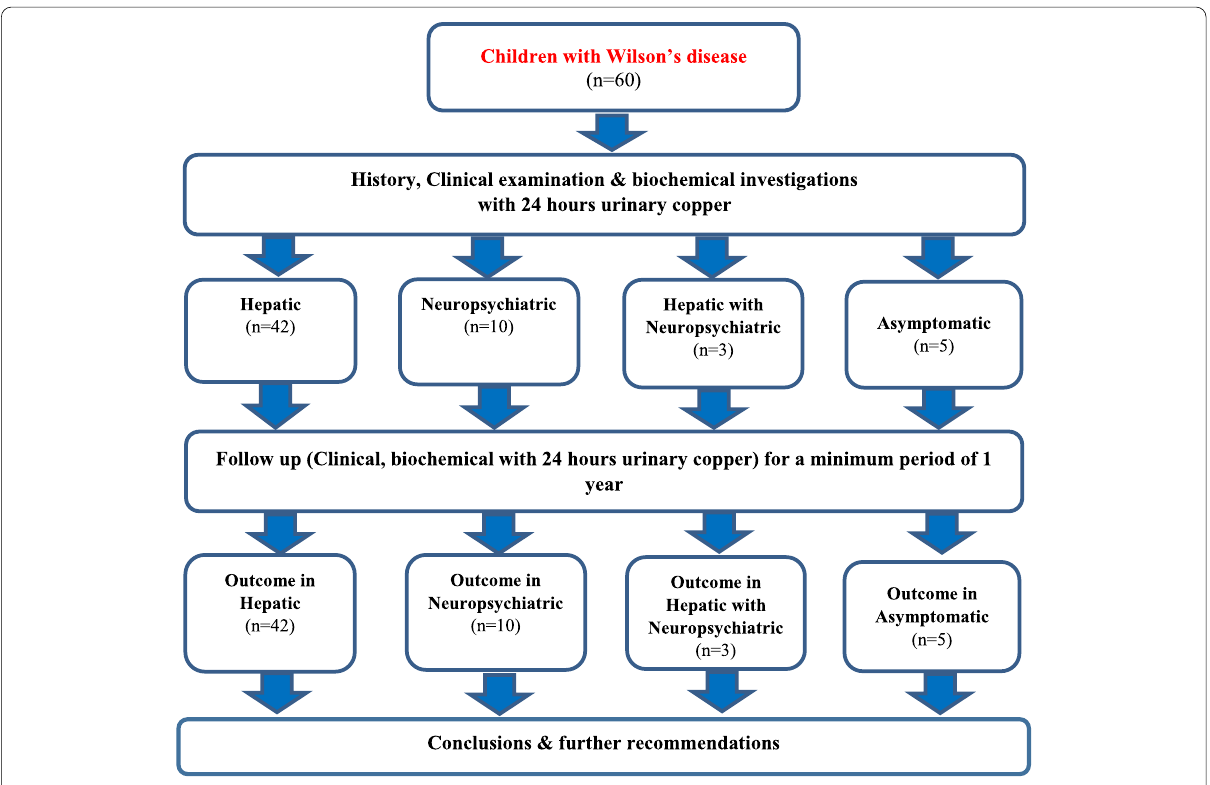
Fig. 1 Study flow chart of Wilson’s disease ( n